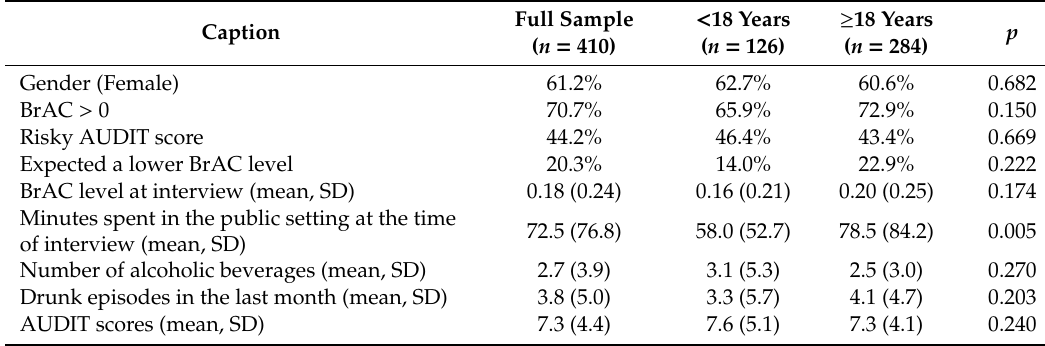
Table 1. Di ff erences by age in demographics and alcohol Table 1. Differences by age in demographics and alcohol use.